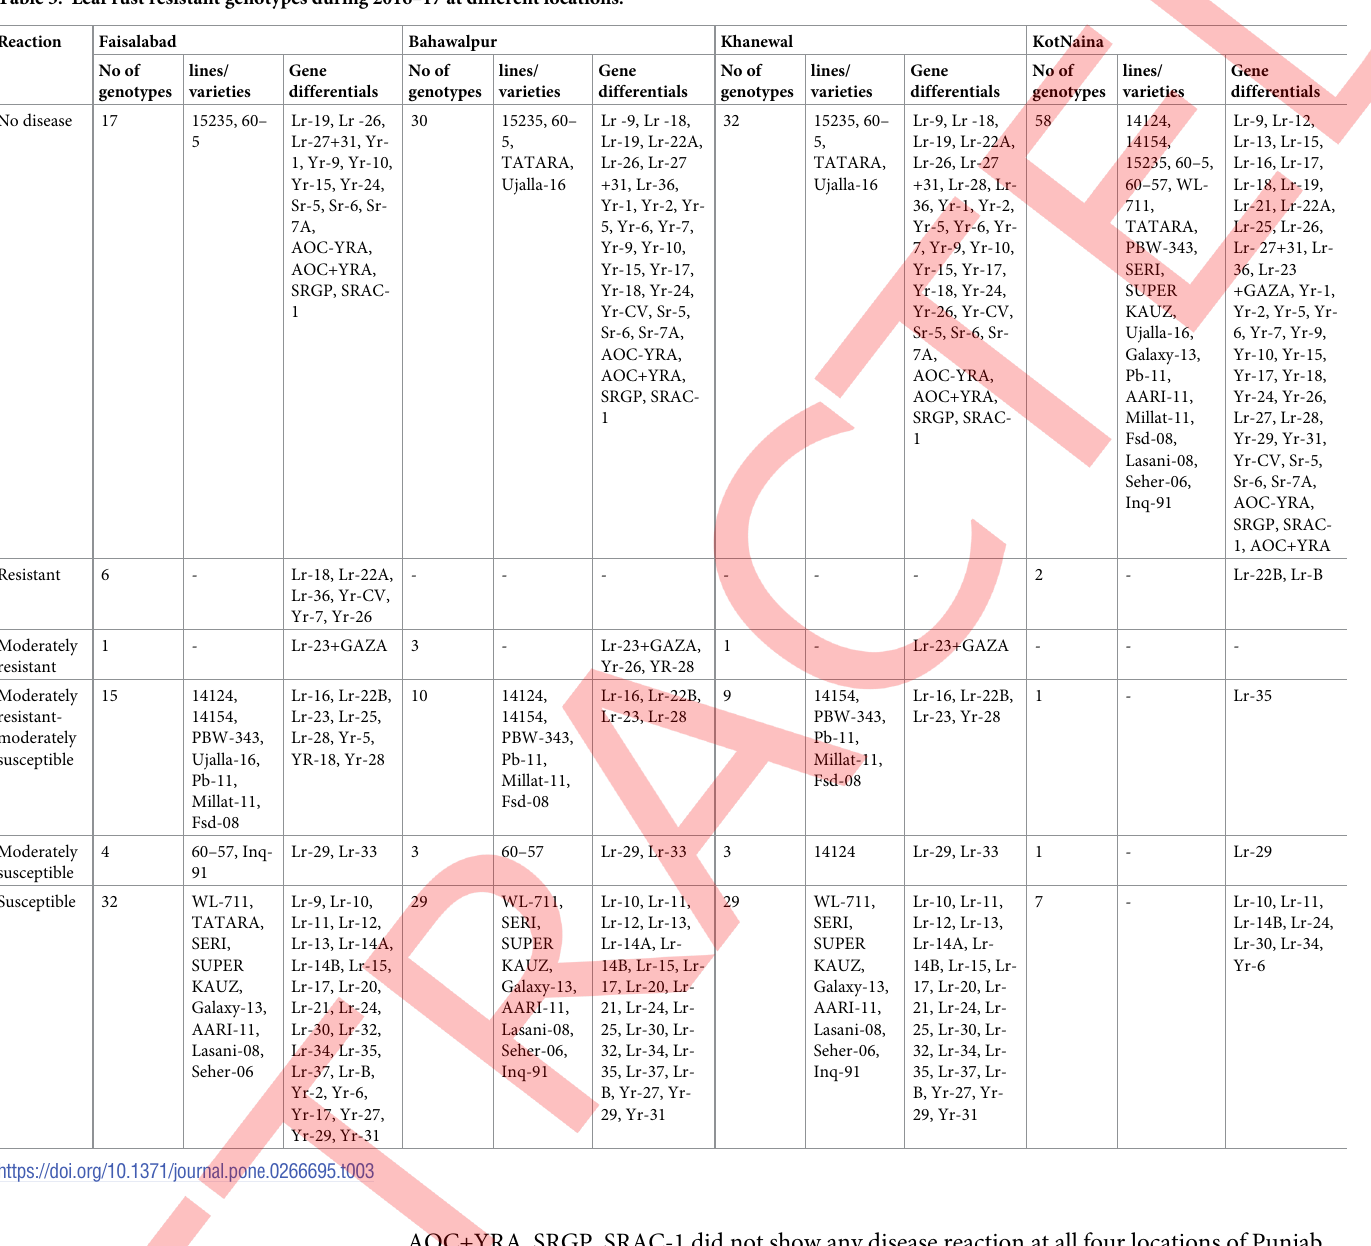
Table 3. Leaf rust resistant genotypes during 2016–17 at different locations.